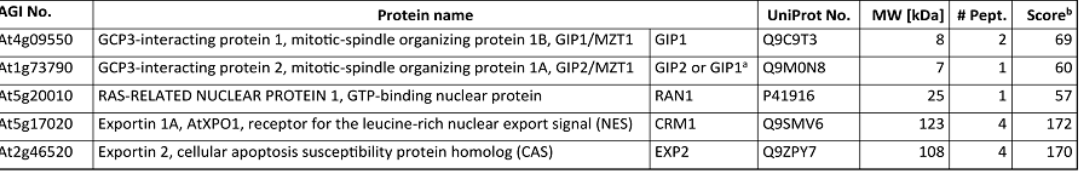
Figure A1. The list of selected proteins copurified with γ -tubulin from Arabidopsis thaliana. Proteins were identified by LC MALDI-TOF MS/MS [2]. The number of matching peptides and the total MASCOT score for each protein are shown. a The only peptide identified matches both GIP1 and GIP2 protein sequences. b Sum of MASCOT scores of all identified